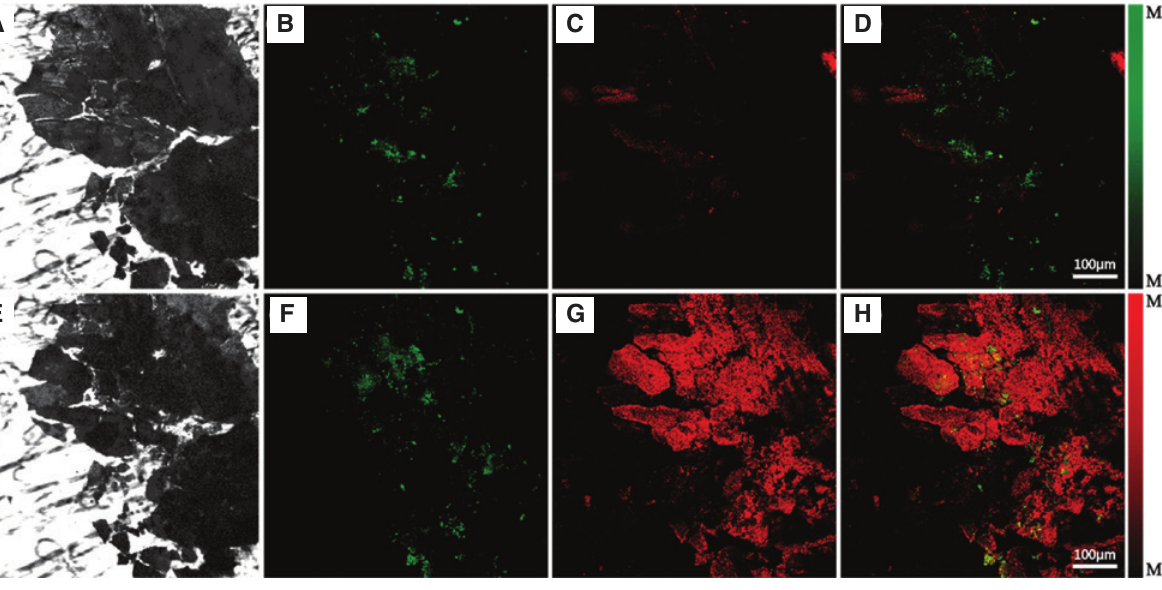
Figure 3: Optical characterization of plasmon-enhanced g-C (A) The bright field optical image of defective g-C of the defective g-C